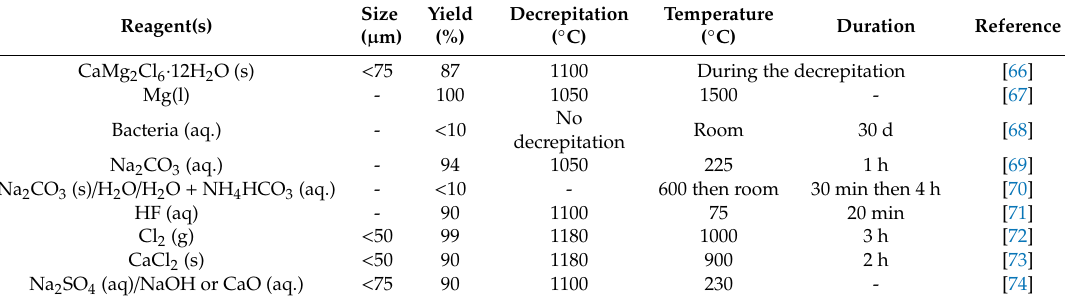
Table 5. Published processes of lithium extraction from spodumene [54].